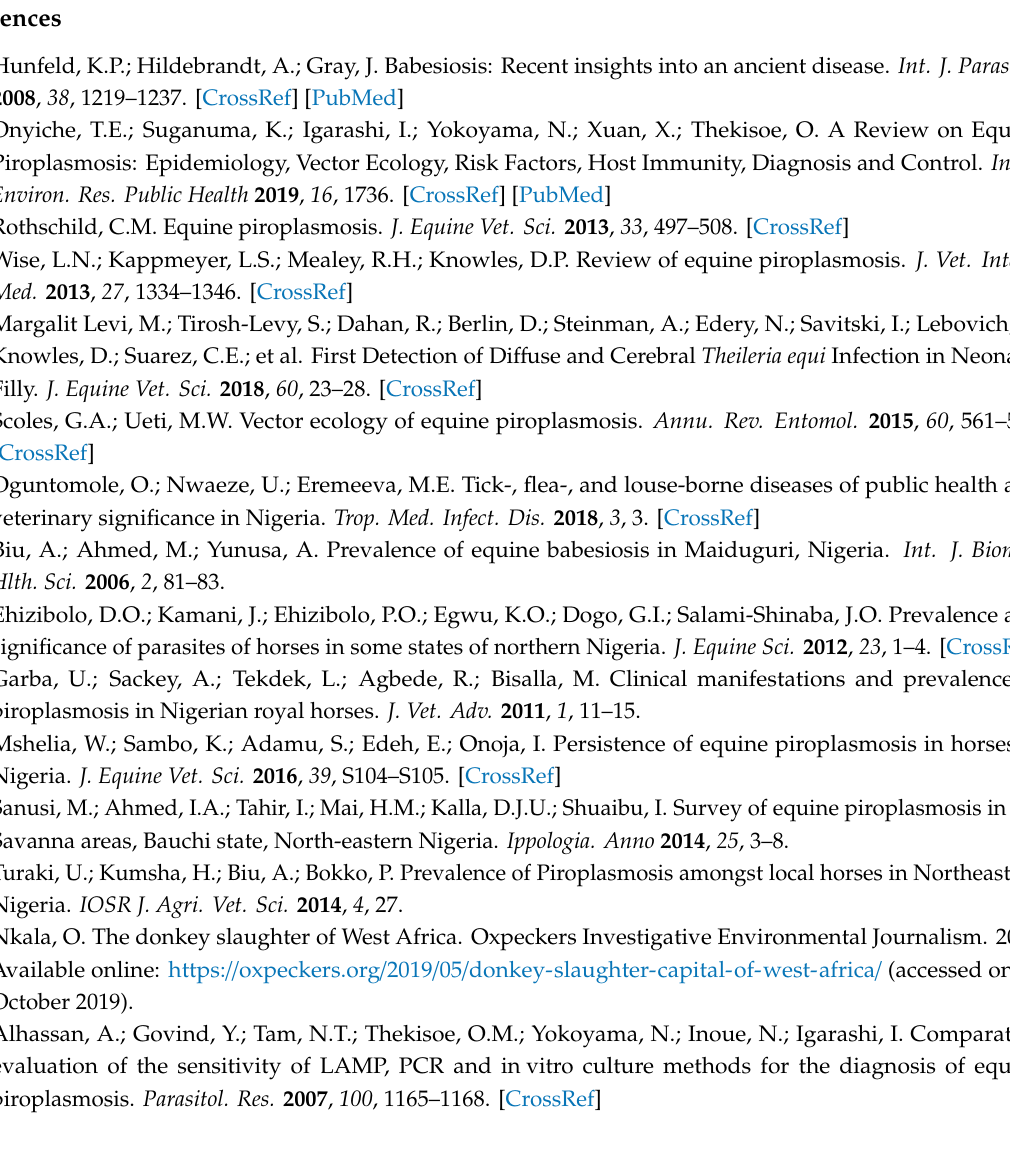
Table S1: Details of the animals used in this study and identification of T. equi and B. caballi infection by PCR, genotyping and